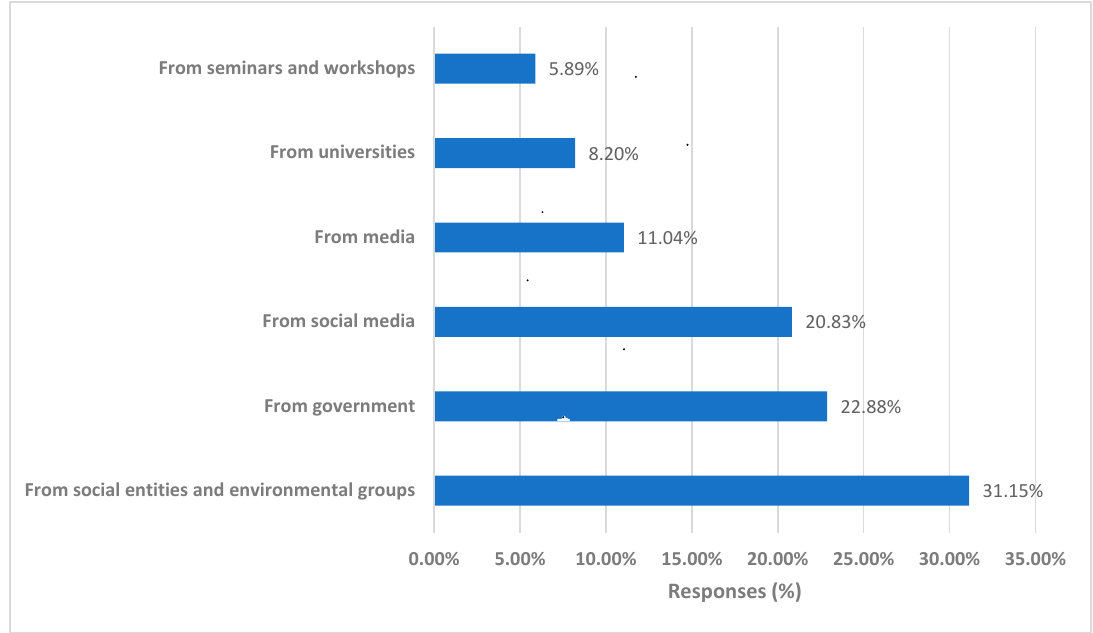
Figure 10. Responses to the question, “If you want information about food waste reduction, which entity seems more preferable for you?”